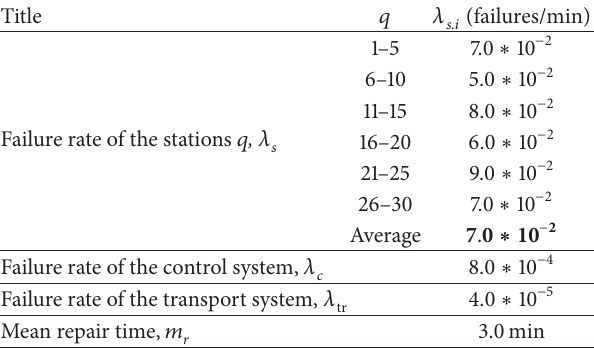
Table 2: Reliability indices of the automated